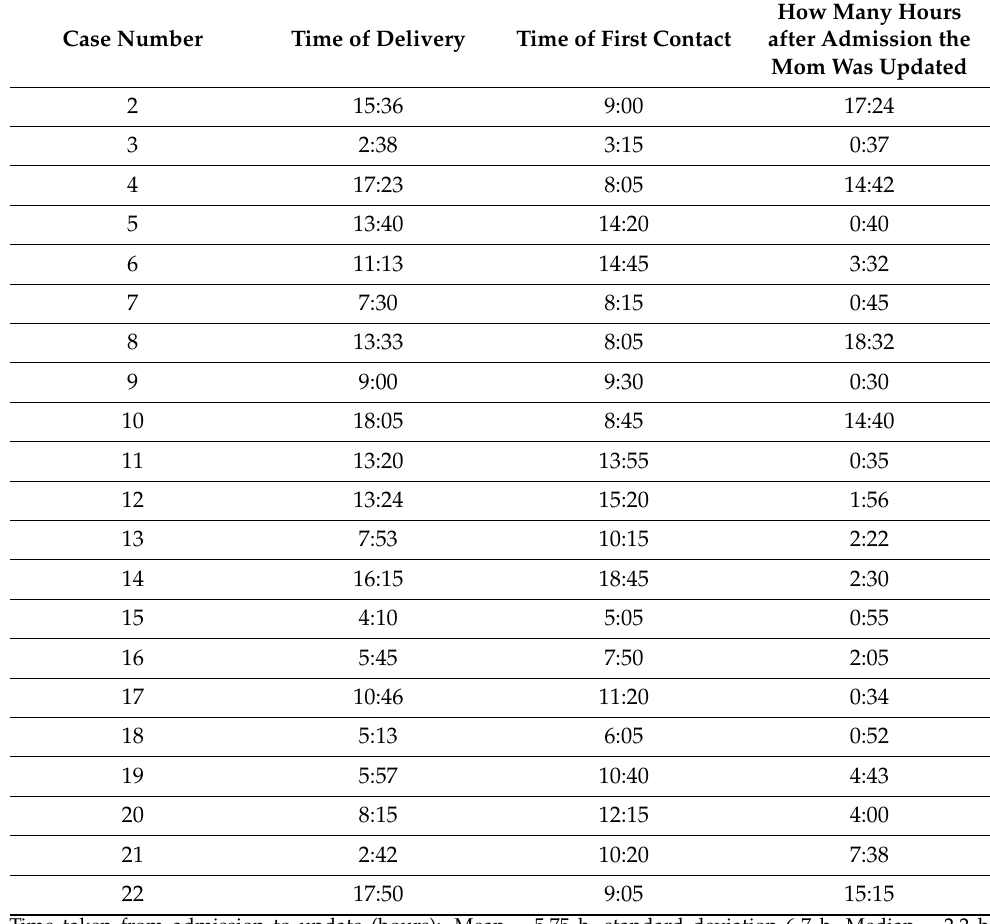
Figure 3. Summary of responses from residents and neonatal nurse practitioners after educational session. Figure 4. Summary of responses from mothers. Table 1. Summary of the Update Times. Case Number